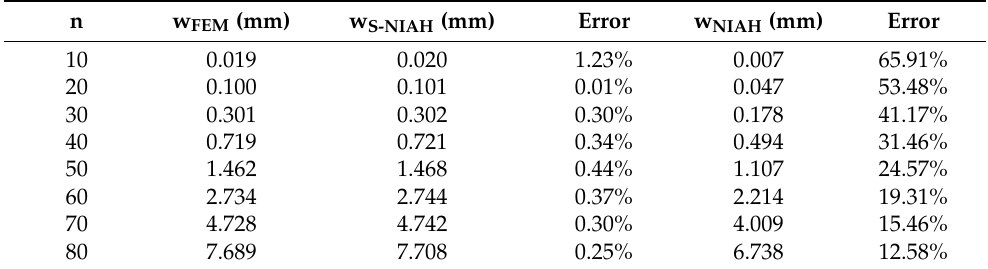
Table 1. Average values of node deflection along thickness direction at centre w FEM , deflection values considering equivalent shear stiffness w S-NIAH , and deflection values without considering equivalent shear stiffness w NIAH under different n.